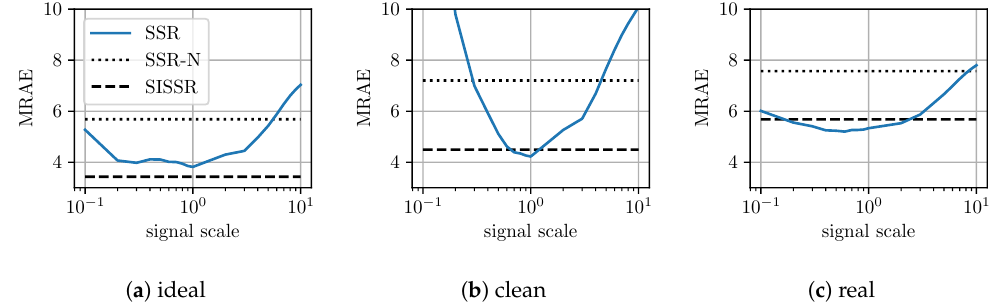
Figure 7. Detailed visualization of the results reported in Tables 2 and 3 for the UNet architecture.